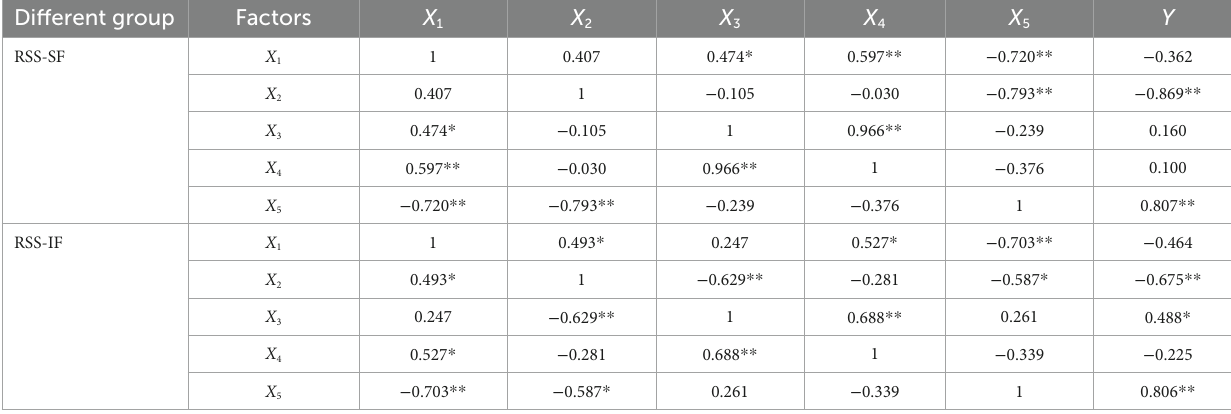
TABLE 1 Correlation coefficients in group RSS-SF and RSS-IF. Different